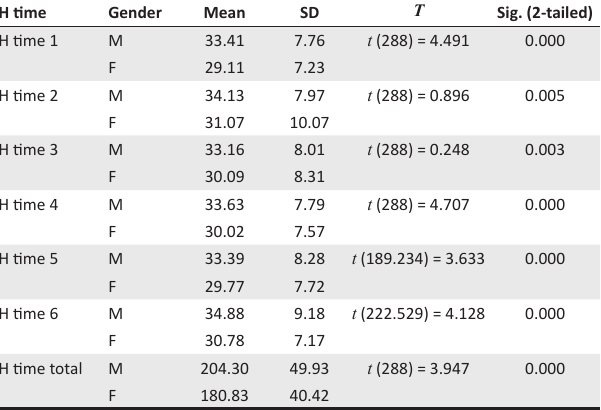
TABLE 4: Independent samples T -test: Comparison of time scores for males ( n = 198) and females ( n = 92) on the CE letter cancellation test. CE time Gender